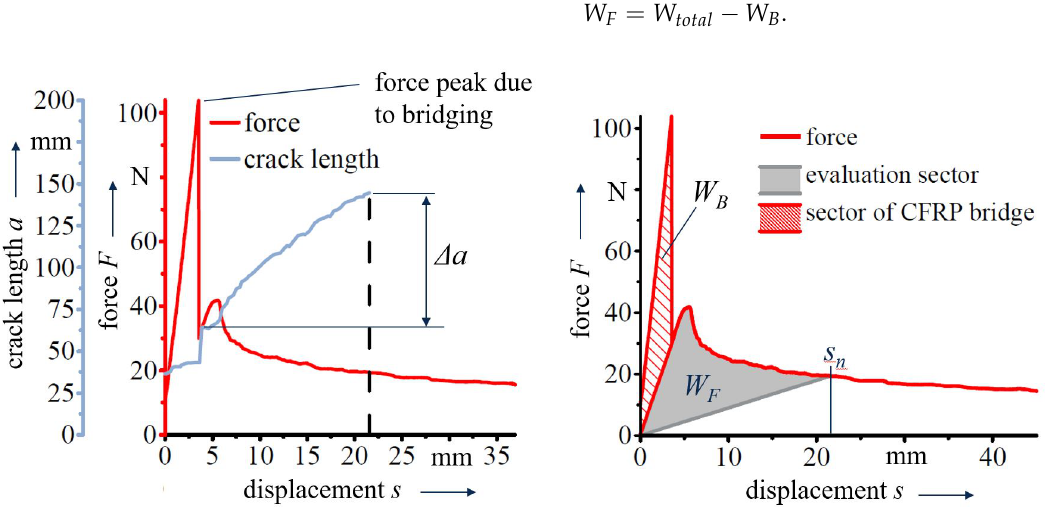
Figure 5. Analysis of energy release rate values accounting for bridging